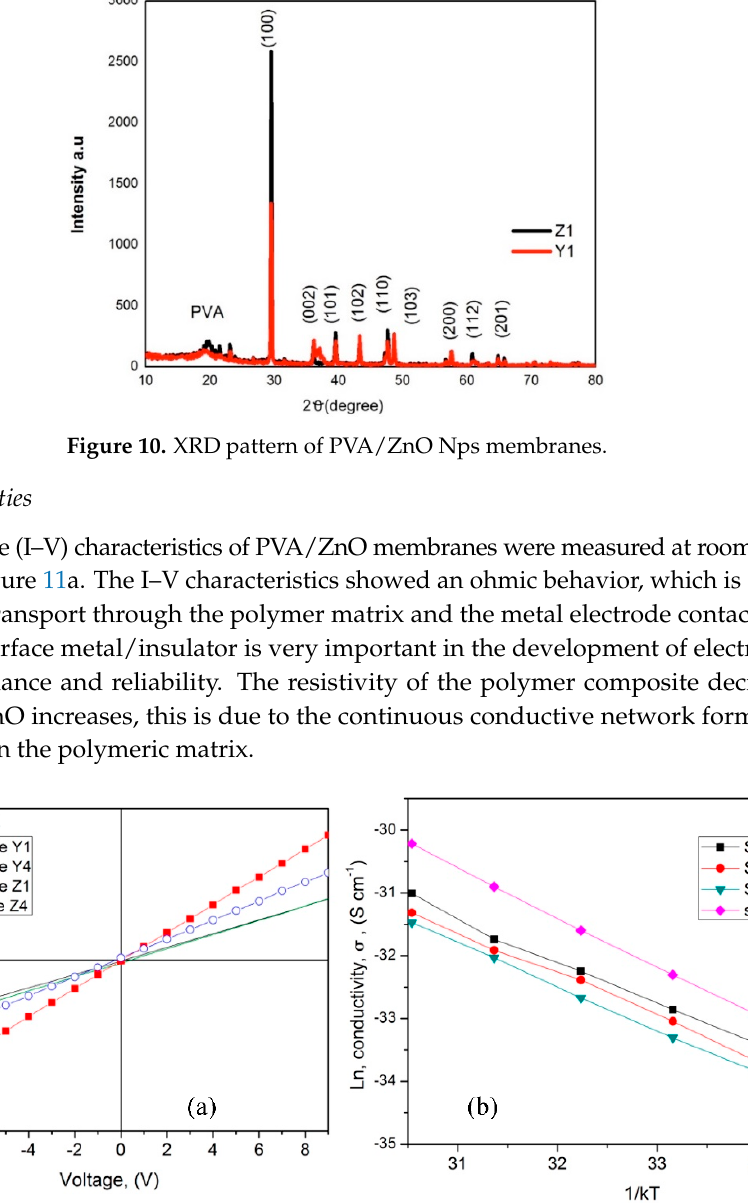
Table 2. Electrical properties for the PVA/ZnO composites membranes.